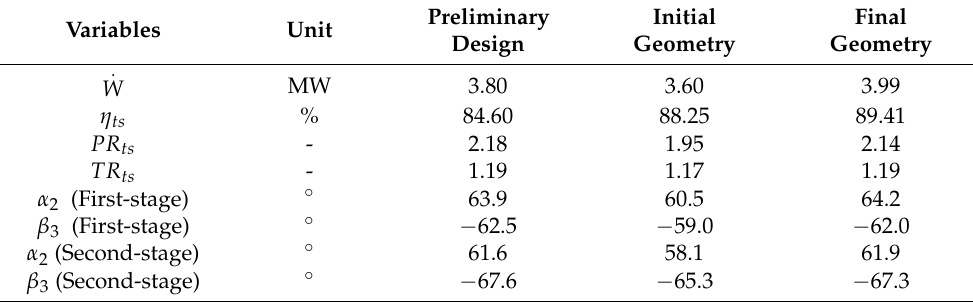
Table 8. Main results of the initial geometry and final geometry.